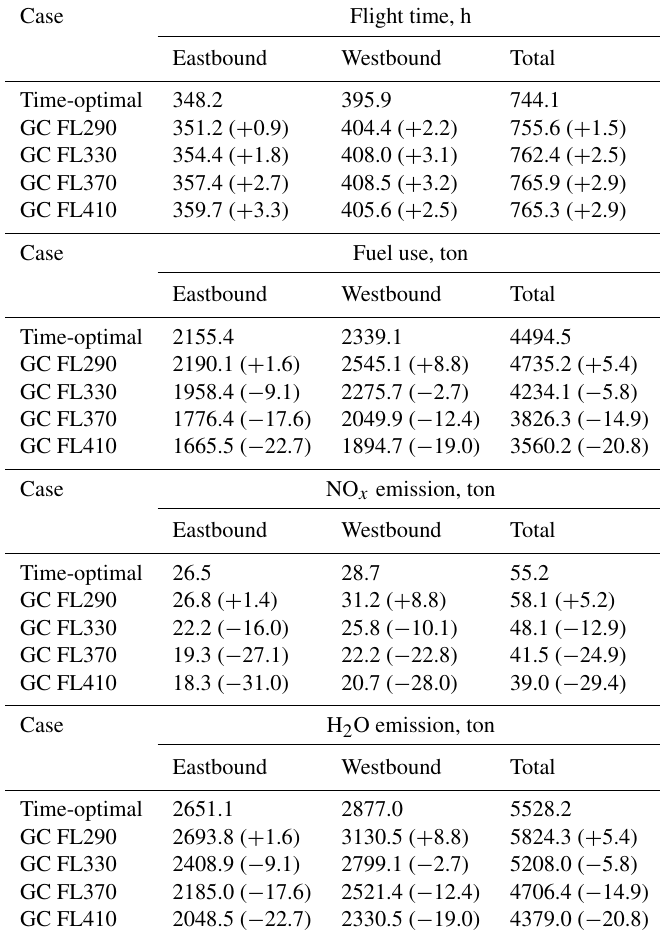
Table 11. Flight time, fuel use, and NO x and H 2 O emissions for the time-optimal and great circle cases obtained from 1-day AirTraf simulations. Eastbound: sum of 52 eastbound flights; Westbound: sum of 51 westbound flights; and Total: sum of 103 flights. Changes (in %) relative to the time-optimal case are given in